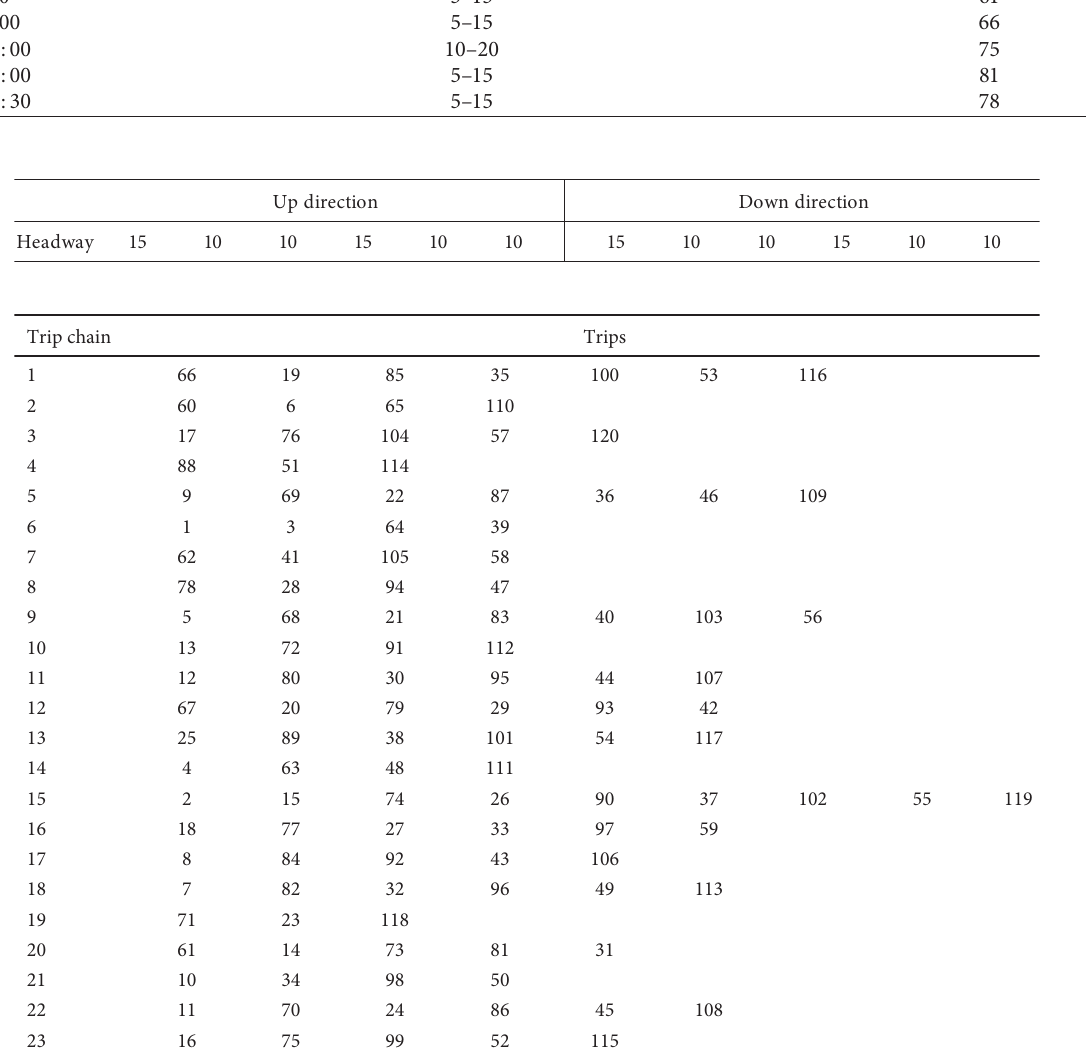
Figure 14: An example of the integrated problem